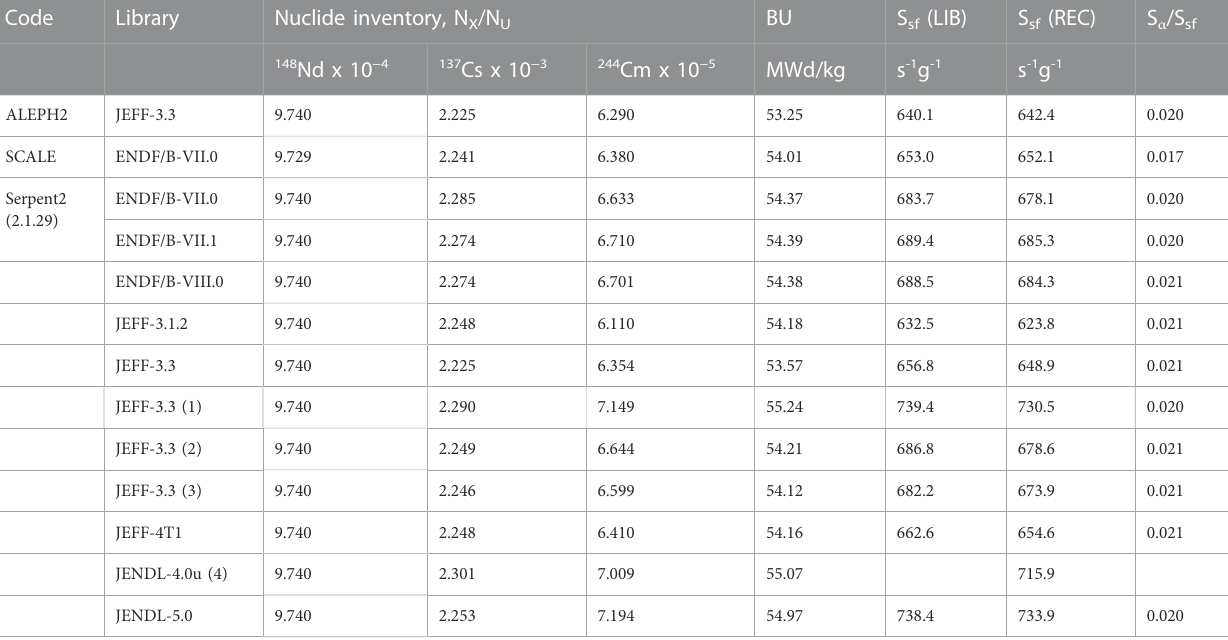
TABLE 4 Nuclide inventory for 148 Nd, 137 Cs and 244 Cm, BU and neutron production due to spontaneous fi ssion S sf and ( α ,n) reactions S α . Results obtained with ALEPH2, SCALE and Serpent2 using different nuclear data libraries are given. The S sf rates are derived by using the data in the library and the decay data and neutron emission data recommended in DDEP (2023) and Santi and Miller